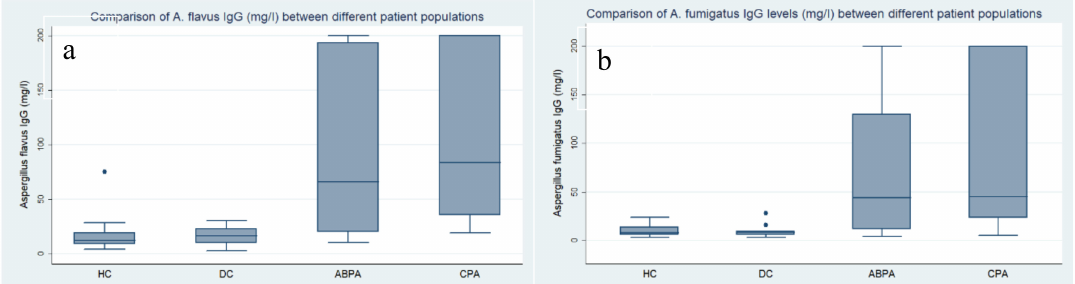
Figure 1. ( a ) Comparison of A. flavus IgG levels between categories; ( b ) Comparison of Aspergillus fumigatus IgG levels between categories. Note: HC, healthy controls; DC, diseased controls; ABPA, patients diagnosed with allergic bronchopulmonary aspergillosis; CPA, chronic pulmonary aspergillosis. ( a , b ) HC and DC had statistically significant di ff erence in Aspergillus -specific IgG levels against both A. fumigatus and Aspergillus flavus allergens from CPA patients ( < 0.001). The di ff erence between HC and ABPA patients was significant in A. flavus IgG levels (0.006) but did not reach statistical significance for A. fumigatus IgG.